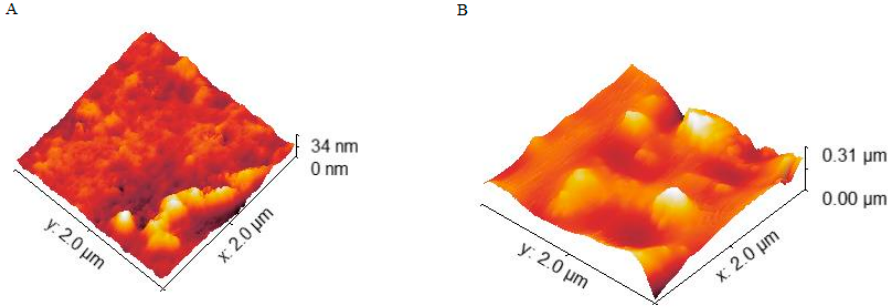
Figure 4. AFM height maps of LB films of 1 exposed to humic acid (HA); image ( A ), and human serum albumin (HSA), image ( B ). The number of layers is 4. See text for details.